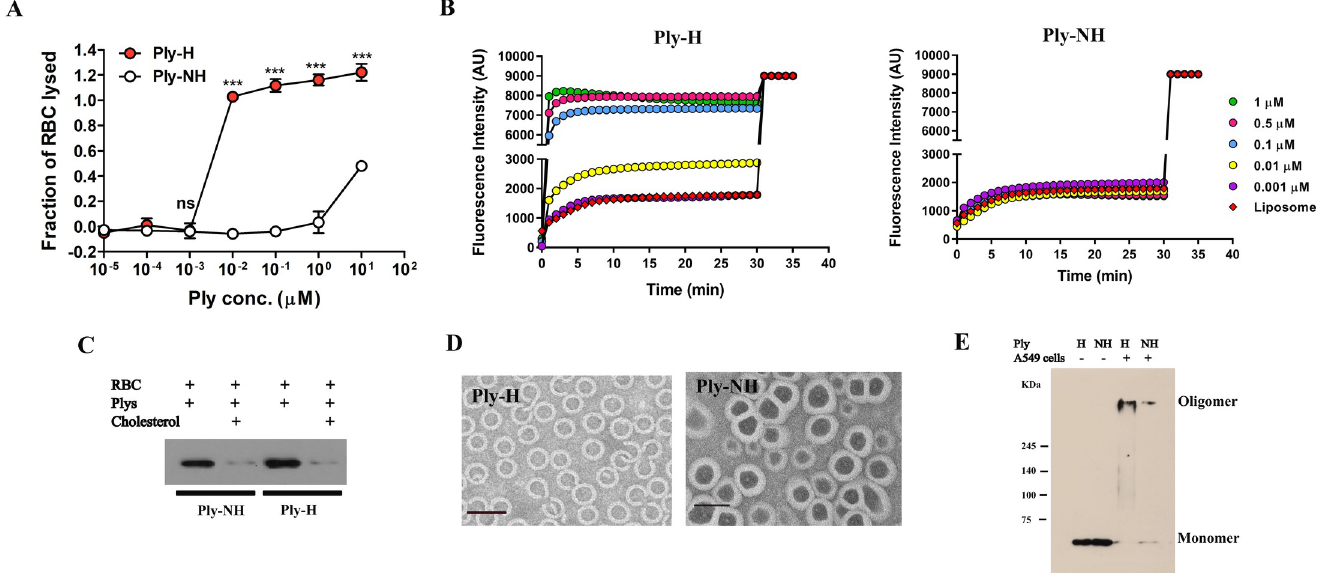
Fig 1. Ply-NH can bind and oligomerize on membranes but is incapable of forming pores. ( A ) Hemolysis of sheep RBCs by purified recombinant Ply-H and Ply- NH at different concentrations. ( B ) Kinetics of calcein (hydrodynamic radii ~ 0.74 nm) release from liposomes upon addition of increasing concentrations of Ply-H and Ply-NH indicating the inability of Ply-NH to form pores on membranes. ( C ) Western blot analysis of Ply-H and Ply-NH (0.01 μ M) following incubation with RBC ghost membranes in the presence of cholesterol (50 μ M) revealing cholesterol binding ability of both Ply-H and Ply-NH. ( D ) Transmission electron micrograph (TEM) showing assembly and oligomerization of Ply-H and Ply-NH on liposomes. Scale bar: 50 nm. ( E ) Visualization of Ply-H and Ply-NH oligomers on A549 cells using SDS-PAGE (5%) followed by immuno-blotting. Higher order oligomers and monomers were observed in samples of A549 cells (10 6 ) treated with either Ply-H or Ply-NH (0.5 μ g). Purified Ply-H and Ply-NH without cells were observed as monomers only (53 kDa). Data information: Experiments are performed thrice and data of representative experiments are presented as mean ± SD of triplicate wells (A). Statistical analysis was performed using Student’s two-tailed unpaired t-test (A). ns, non-significant; ��� p <